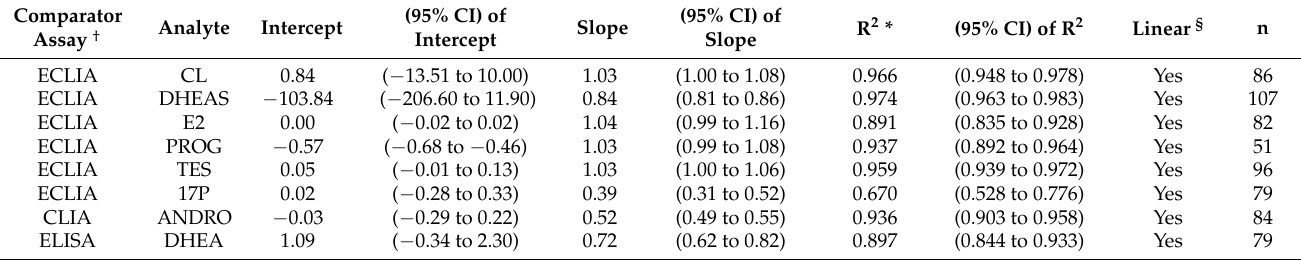
Table 3. Results from Passing and Bablok regression analysis comparing the LC-MS/MS method ( y -axis) and routine IAs ( x -axis) for 17-OH-progesterone (17P), androstenedione (ANDRO), cortisol (CL), dehydroepiandrosterone (DHEA), dehydroepiandrosterone sulfate (DHEAS), estradiol (E2), progesterone (PROG), and testosterone (TES).